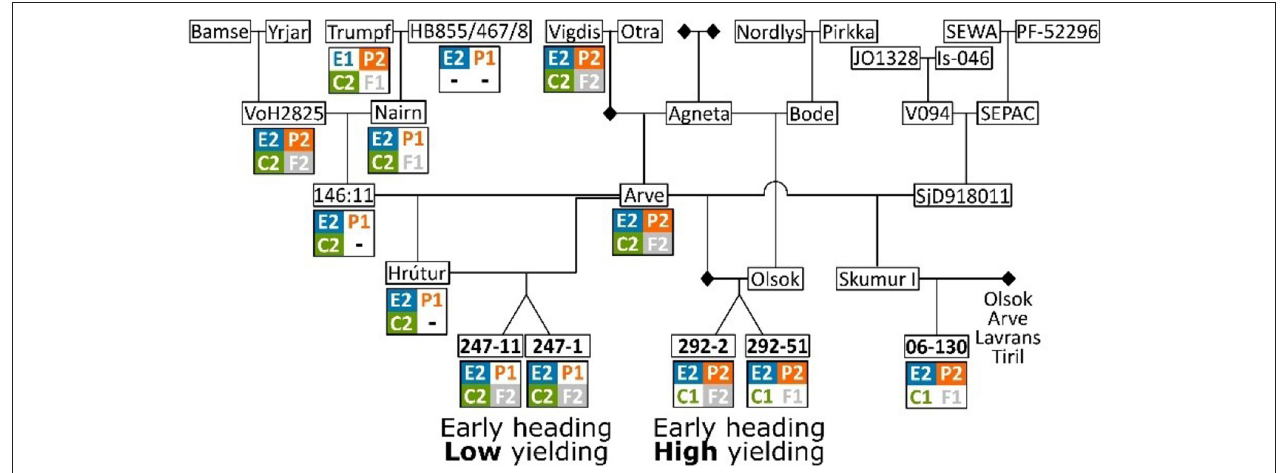
FIGURE 5 | Pedigree of five Icelandic barley breeding lines: “247-1”, “247-11”, “292-2”, “292-51”, and “06-130”. Haplotypes for the four different genes re-sequenced are shown below each genotype. When possible, haplotypes are imputed for unsequenced genotypes. The full pedigree can be found in Supplementary Figure 1